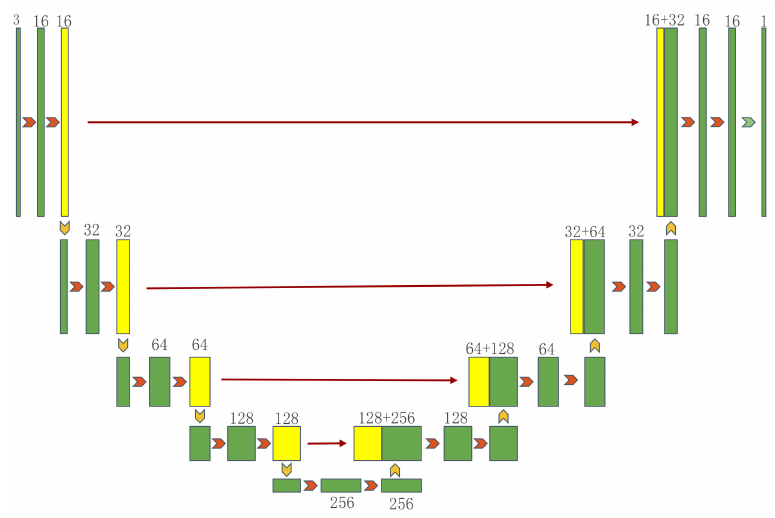
Figure 1. The architecture of